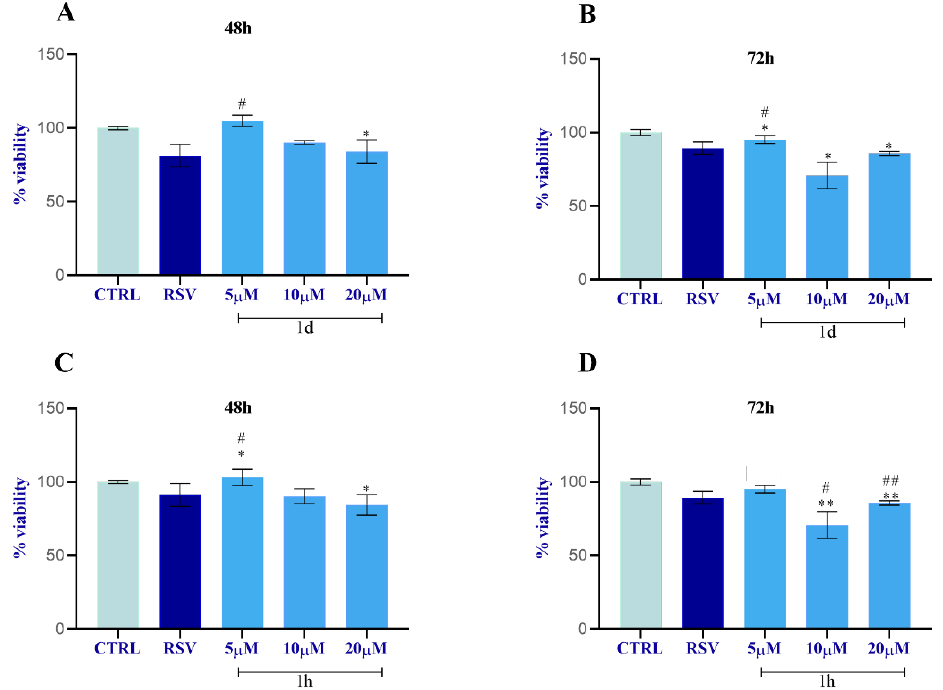
Figure 4. HUVECs viability study after incubation with 1d ( A , B ) and 1h ( C , D ) at 5, 10, and 20 µ M. Data were calculated as means ± SD and compared to CTRL (cells treated with 0.1% DMSO); RSV: cells treated with 10 µ M of RSV. * Significance in respect to CTRL: * p < 0.05; ** p < 0.001. # Significance respect to RSV: # p < 0.05; ## p < 0.001.